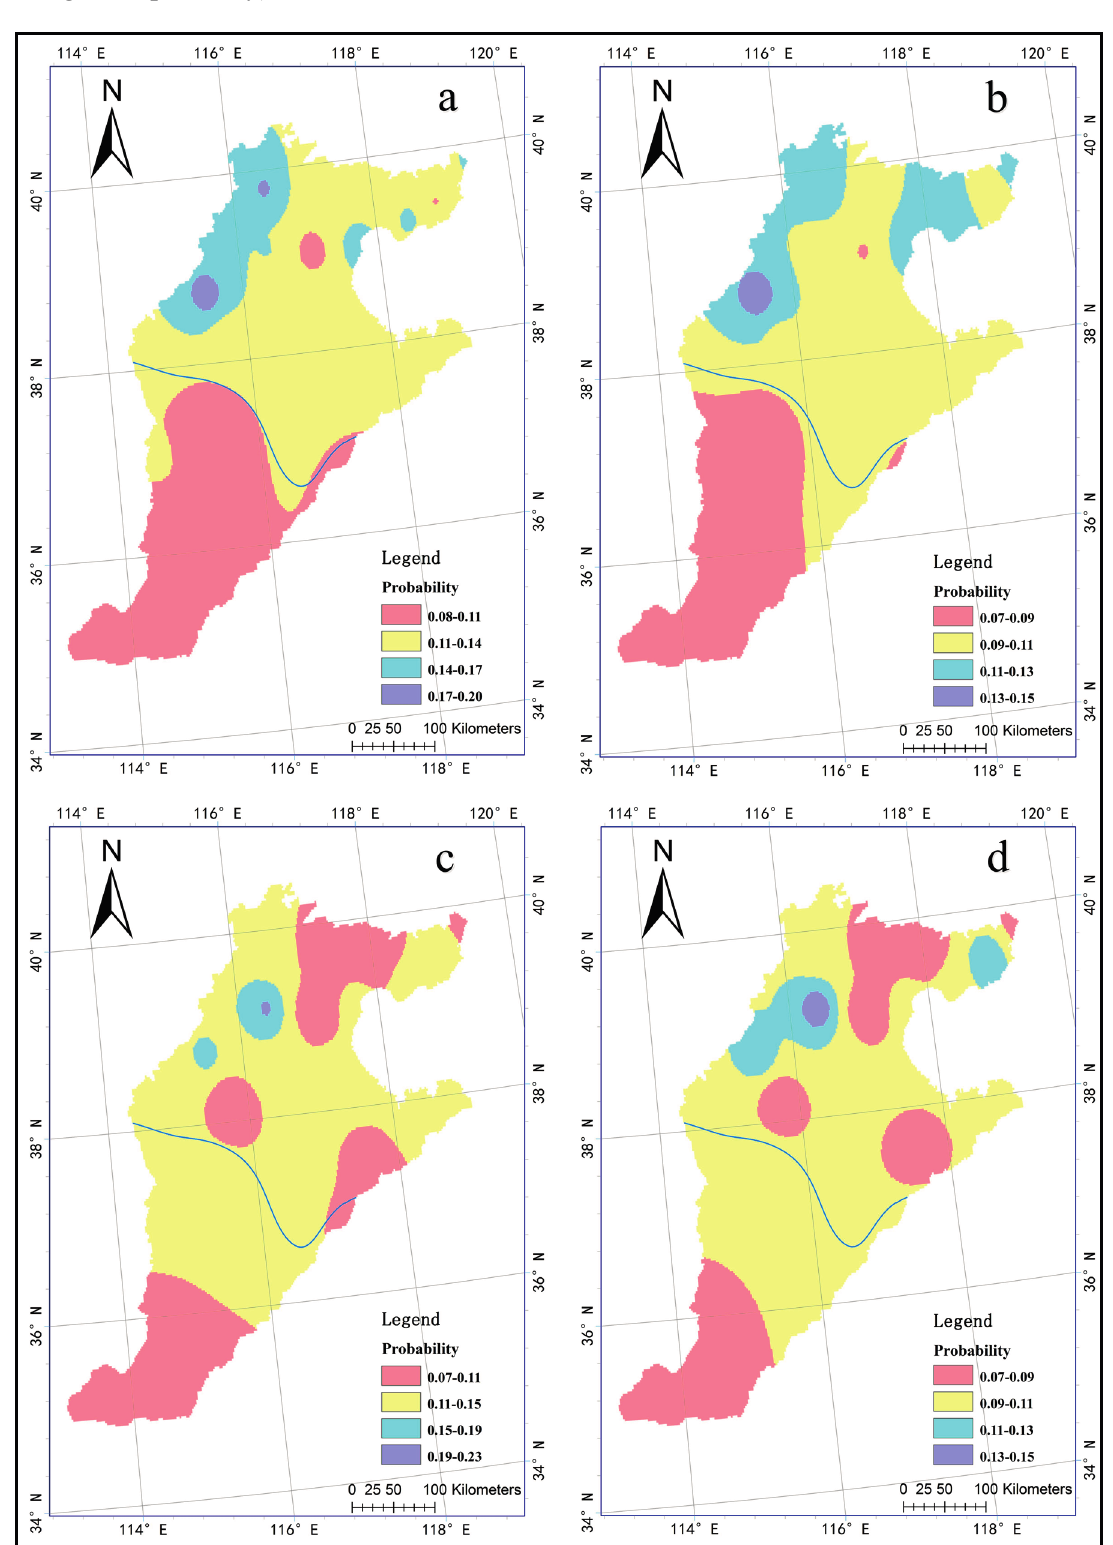
Figure 6. Spatial distribution of the probability of seasonal DFCEs on the NCP. ( a , b ) for continuous drought in spring-summer and spring drought & summer flood, respectively; ( c , d ) for continuous drought in summer-autumn and summer flood & autumn drought,